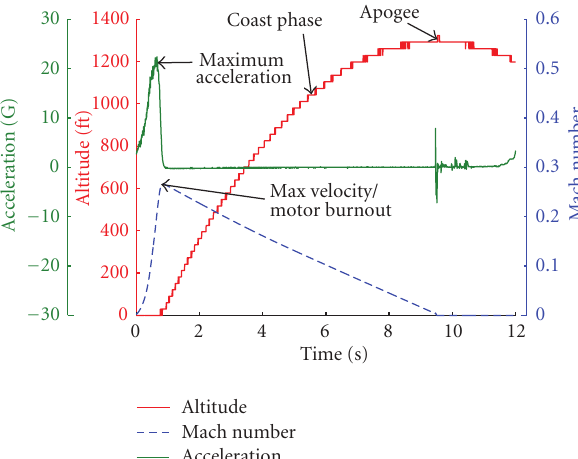
Figure 11: R-DAS flight-data from test launch of the flight vehicle powered by the ALICE